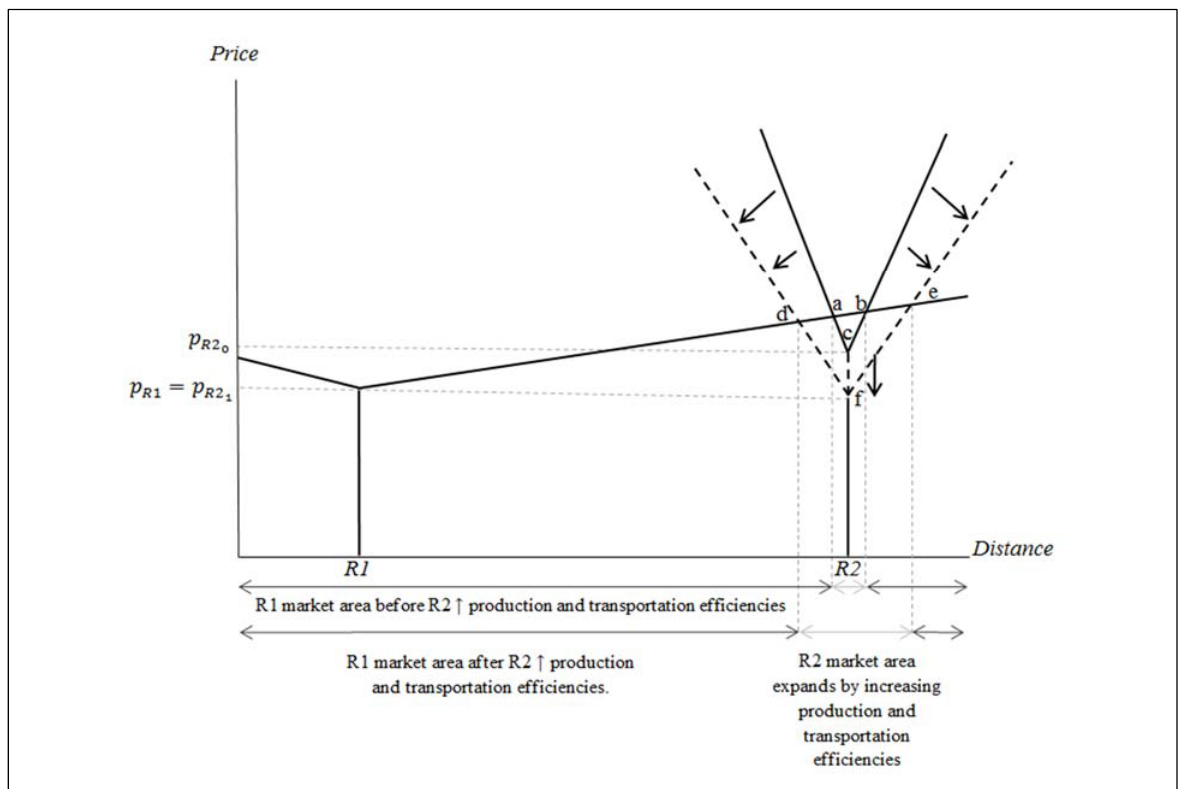
Figure 1. Hotelling’s Two-Region Spatial Competition Model and the Effect of Increased Production and Transportation